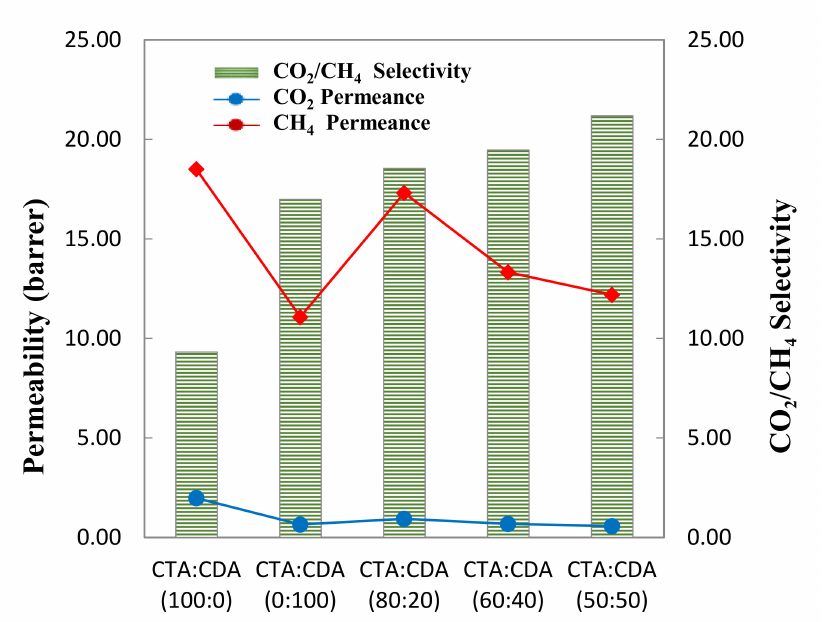
Figure 6. Separation performance of fabricated membranes as a function of blend